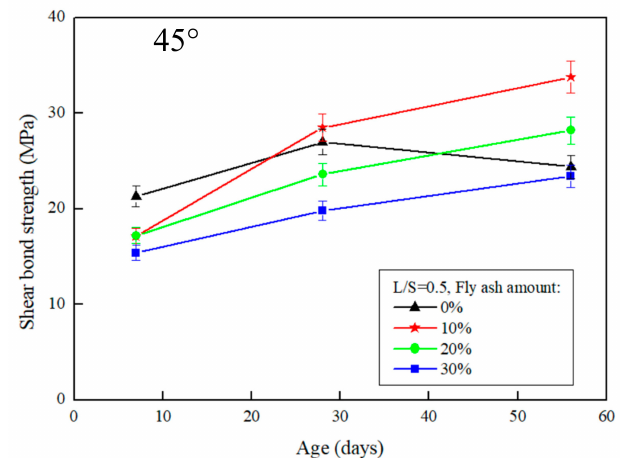
Figure 4. The e ff ect of di ff erent fly-ash amount on the slant shear test of FGG when L / S = 0.5 and repair angle was 45 ◦ .